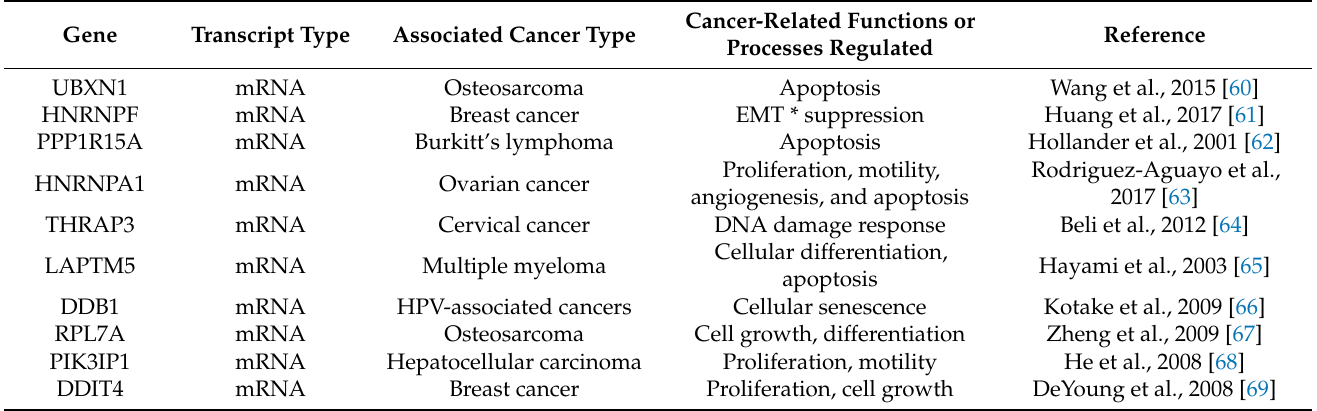
Table 2. The list of top 10 underexpressed tumor suppressor candidate protein-coding transcripts in MCL cases.